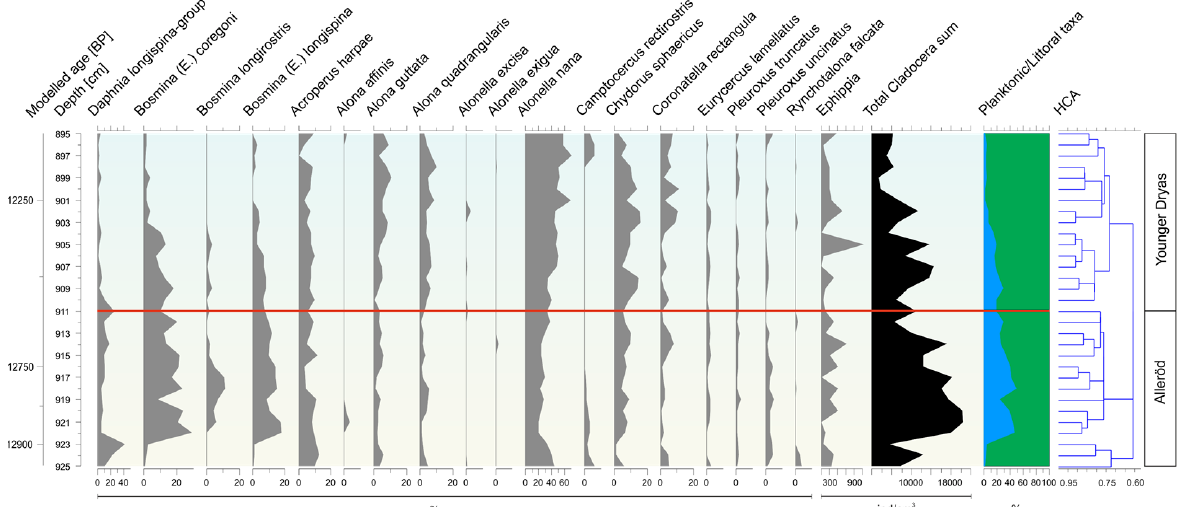
Figure 4. Diagram of percentage composition and the total sum of Cladocera specimens in sediments of the core Z ‐ 3 determined for Alleröd/Younger Dryas transition. HCA: Hierarchical Cluster Analysis.